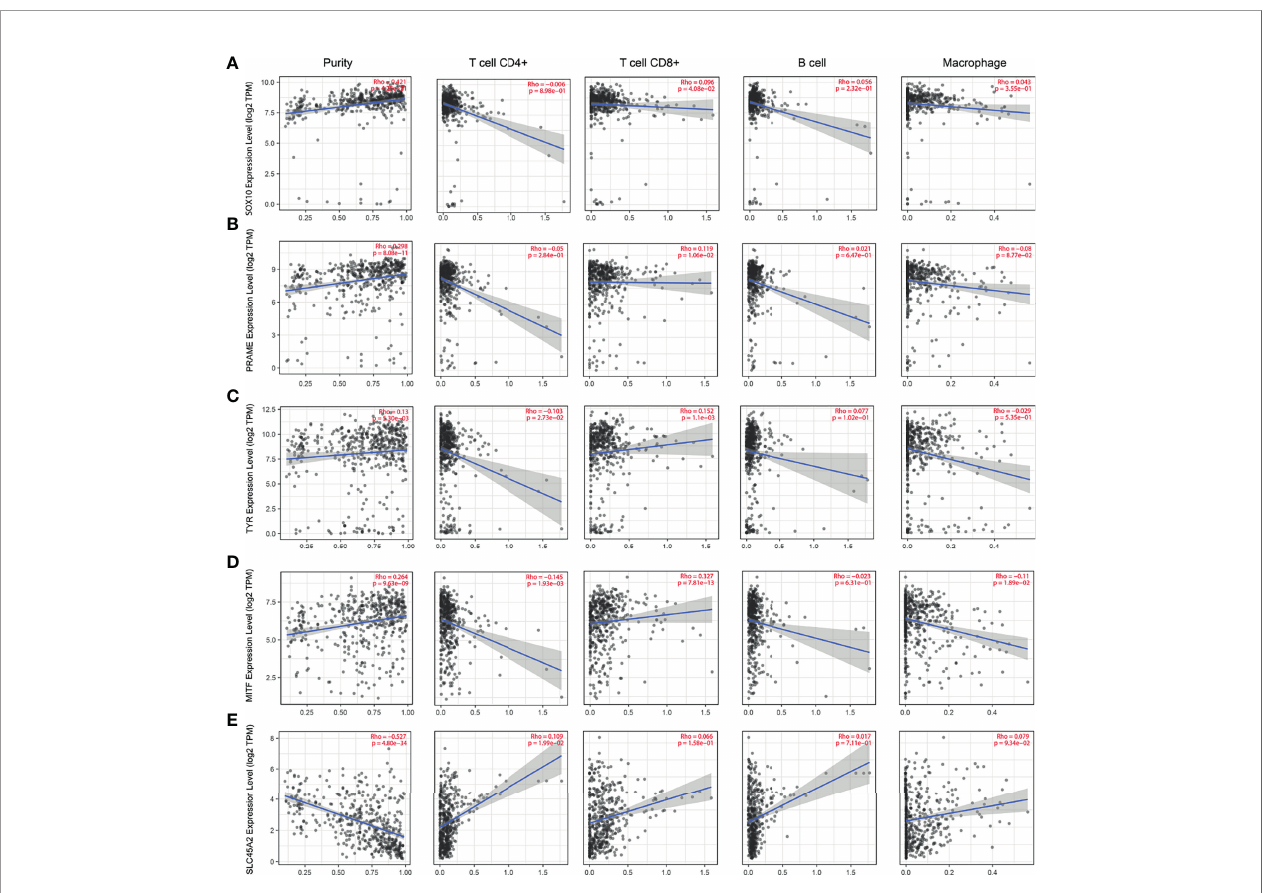
FIGURE 7 | Correlation between the candidate genes and immune cell in fi ltration of SOX10, PRAME, TYR, MITF, and SLC45A2. The correlation between the expression of A – E candidate genes: (A) SOX10 , (B) PRAME , (C) TYR , (D) MITF , and (E) SLC45A2 and the in fi ltration level of immune cells (tumor purity, CD4+ T cells, CD8+ T cells, B cells, and macrophages from left to right, respectively).